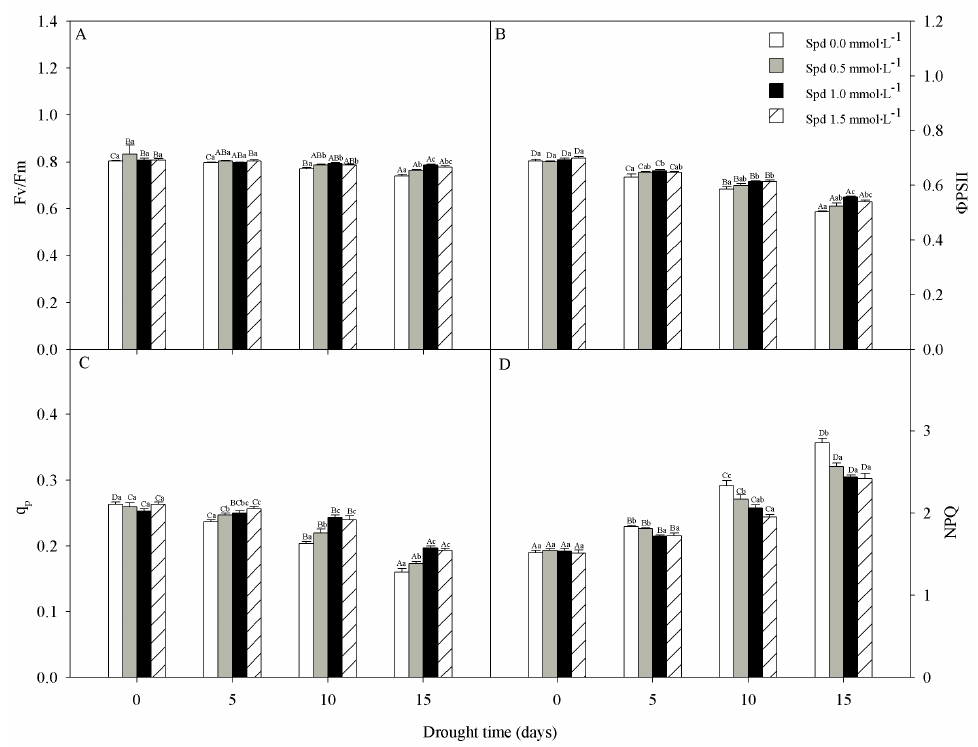
Figure 3. ( A ) Maximal quantum yield of PSII photochemistry (Fv/Fm), ( B ) actual quantum yield of photochemical energy conversion in PSII ( φ PSII), ( C ) photochemical quenching coefficient (q p ), and ( D ) nonphotochemical quenching coefficient (NPQ) of Hordeum jubatum shoots not Spd treated (S0) or pretreated with 0.5 mM Spd (S1), 1.0 mM Spd (S2), and 1.5 mM Spd (S3) under drought stress. Days 0, 5, 10, and 15 correspond to CK, D1, D2, and D3 in the experimental treatment, respectively. The capital letters denote significant differences among the different drought intensities from the shoots under the same concentrations of Spd. The small letters denote significant differences among the different concentrations of Spd from shoots under the same drought intensity. The differences in each parameter were tested by a one − way analysis of variance (ANOVA) at the p < 0.05 level. The bars represent the means ± SEs (n = 3).